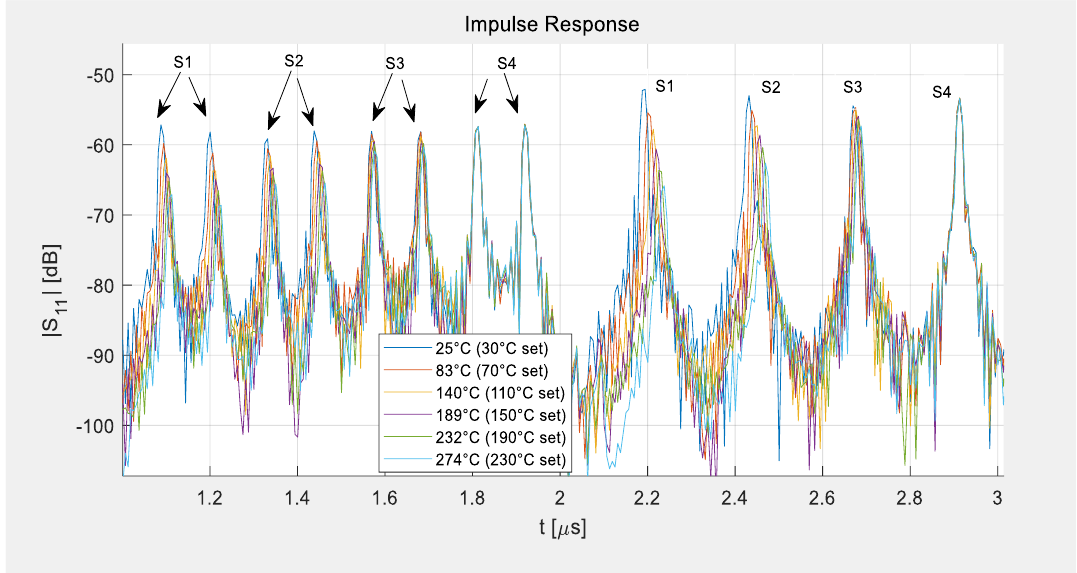
Figure 5. Shift of delay time due to heating of the sensors. Sensor 1 demonstrates the full shift of the delay time as it was placed at the center of the furnace, while the other sensors see less and less heat and sensor 4 is practically at room temperature and hence no time-shift occurs.